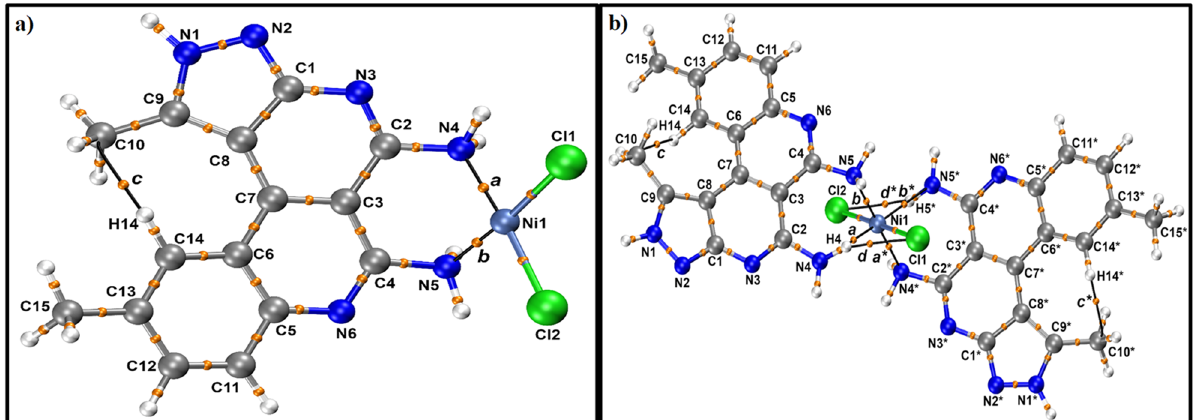
Figure 12. ( a ) AIM molecular graph for L4-NiCl 2 . Bond Critical Points (orange spheres) and Bond Paths (solid dashed black lines), ( b ) AIM molecular graph for 2L4-NiCl 2 Bond Critical Points (orange spheres) and Bond Paths (solid dashed black